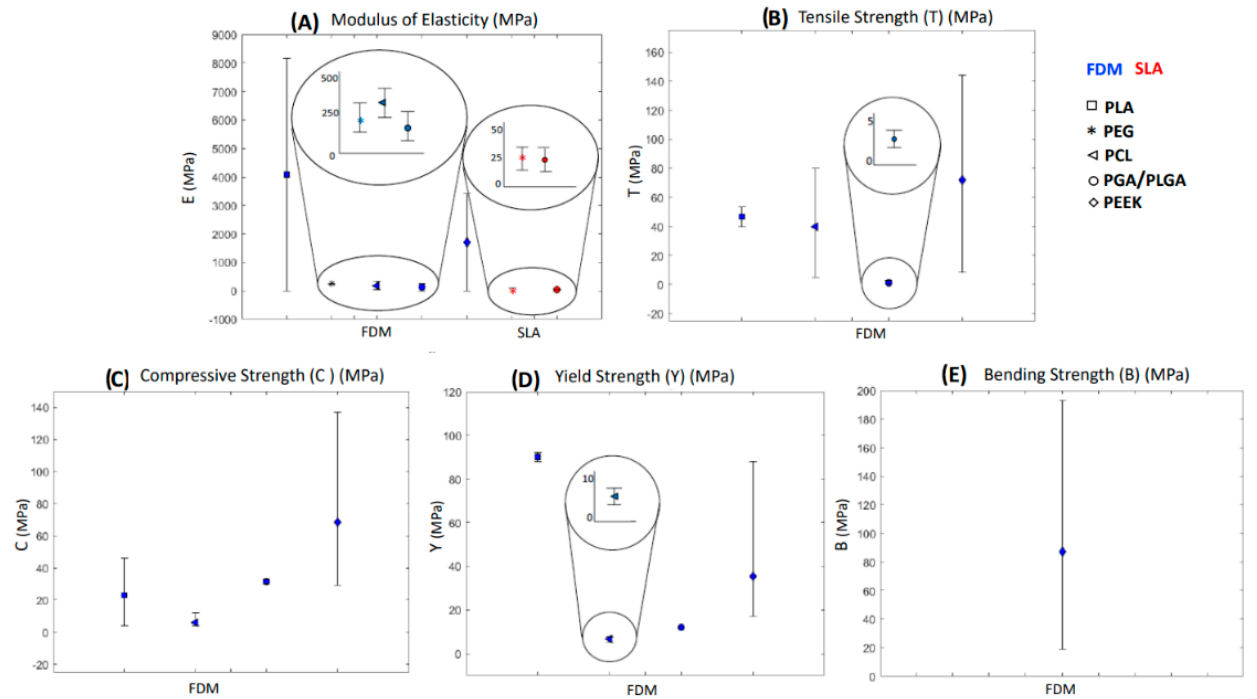
Figure 1. Mechanical properties reported vs. AM method reviewed. ( A ) Modulus of elasticity; ( B ) tensile strength; ( C ) compressive strength; ( D ) yield strength; ( E ) bending strength. Blue markers are for FDM, and Red Markers are for SLA. (For interpretation of the references to color in this figure legend, the reader is referred to the web version of this article.).